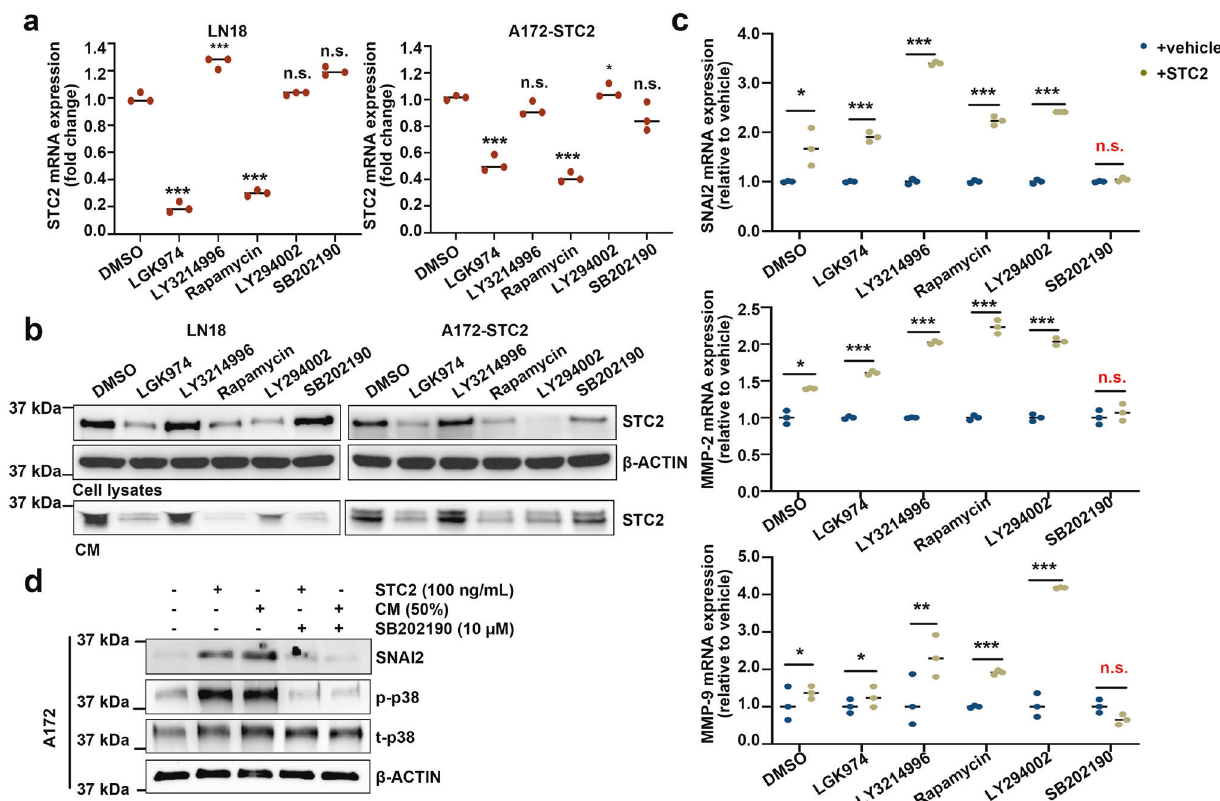
Fig. 5 Secreted STC2 regulates SNAI2 and MMPs through p38 MAPK pathway. a , b LN18 and A172-STC2 cells were treated with small molecule signaling pathway inhibitors (LGK974, 500 nM; LY3214996, 50 nM; Rapamycin, 10 nM; LY294002 1 µM; and SB202190, 10 µM) for 48 h and STC2 expression was detected by real-time PCR ( a ) and Western blot analysis ( b ). Means ± SD; n = 3; On-way ANOVA, *** ī < 0.001. c Wild- type A172 cells were co-treated with small molecule signaling pathway inhibitors and recombinant STC2 (100 ng/mL) for 48 h and SNAI2 , MMP- 2 , and MMP-9 mRNA expressions were determined by real-time PCR. The relative mRNA levels were calculated against vehicle control of each inhibitors. Small molecule inhibitors were added 30 min prior to recombinant STC2 treatment. Means ± SD; n = 3; Student ’ s two tailed t-test, * p < 0.05, ** p < 0.01, *** p < 0.001. d A172 cells were treated with recombinant STC2 (100 ng/mL) or STC2-containing CM (50%) with or without p38 MAPK inhibitor SB202190 for 48 h. SNAI2 protein expression along with phosphorylated p38 (p-p38) and total p38 (t-p38) proteins were determined by Western blot